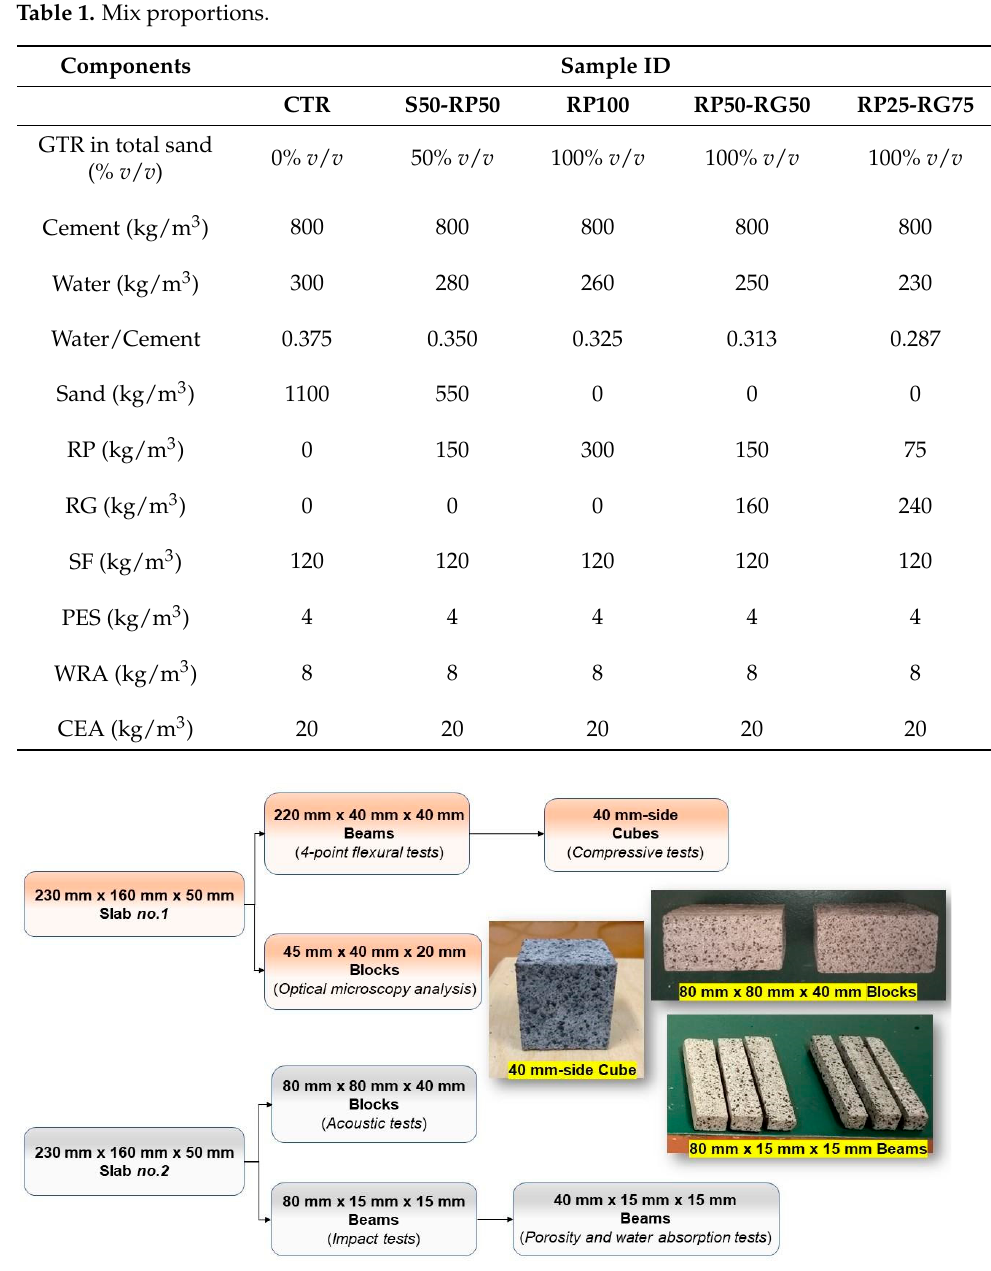
Figure 4. Set of specimens for experimental testing.